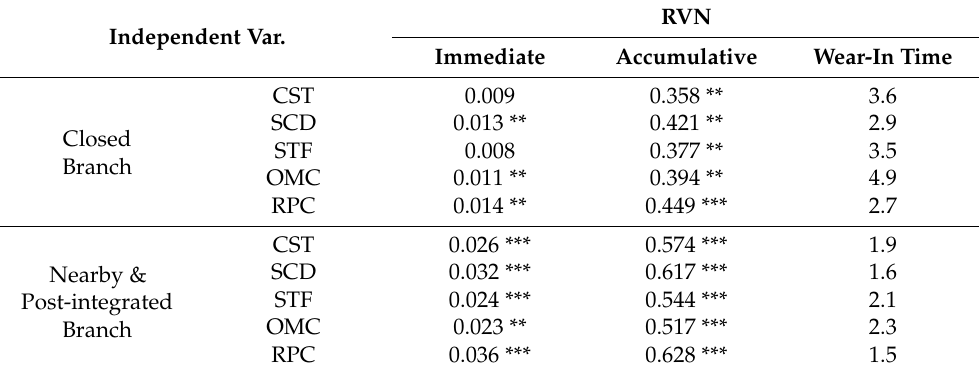
Table 15. The test for generalized impulse response functions (GIRFs). Independent Var.